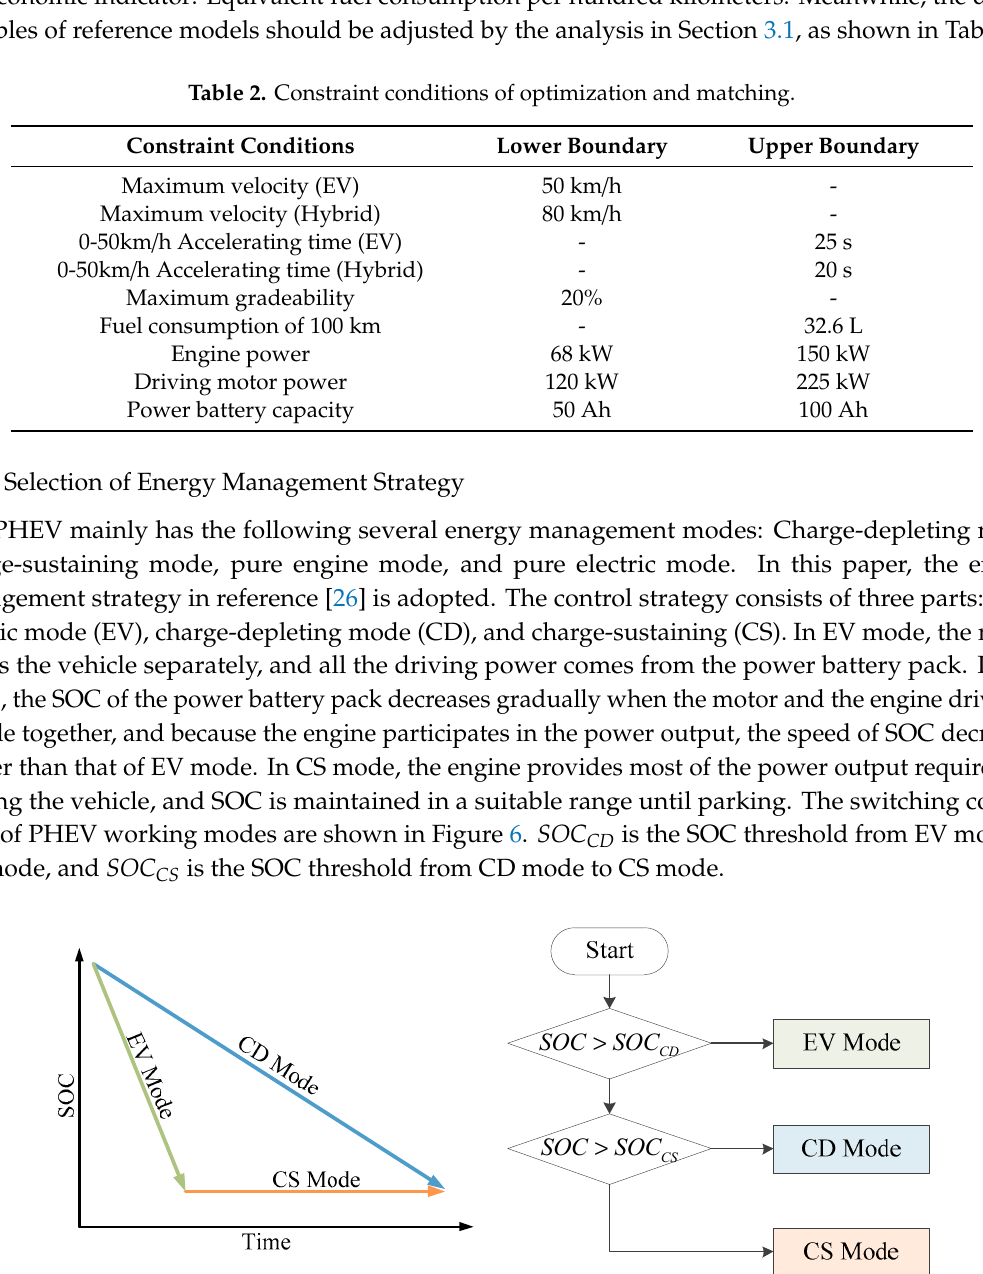
P P Q = Figure 7. Integrated optimization platform based on Isight. 4. Multi-Objective Optimization Considering Fuel Economy and Lightweight Aiming at the problem that parameter matching needs to weigh different design objectives, a multi-objective optimization matching method is proposed. When matching power sources, factors of lightweight, fuel economy, power performance, emission and cost are usually considered. This paper does not consider emission performance, the cost is achieved through lightweight. When the engine, motor and battery are lightweight, the mass is smaller, and the cost is lower. Therefore, this paper adopts weight method and non-normalization method respectively, and considers fuel economy and lightweight as the objectives to optimize PHEV power source components. The fuel economy of vehicle is usually measured by the fuel consumption of 100 kilometers under certain operating conditions. However, PHEV can provide power either from fuel or from battery, the equivalent fuel consumption of 100 kilometers is used to measure the fuel economy of